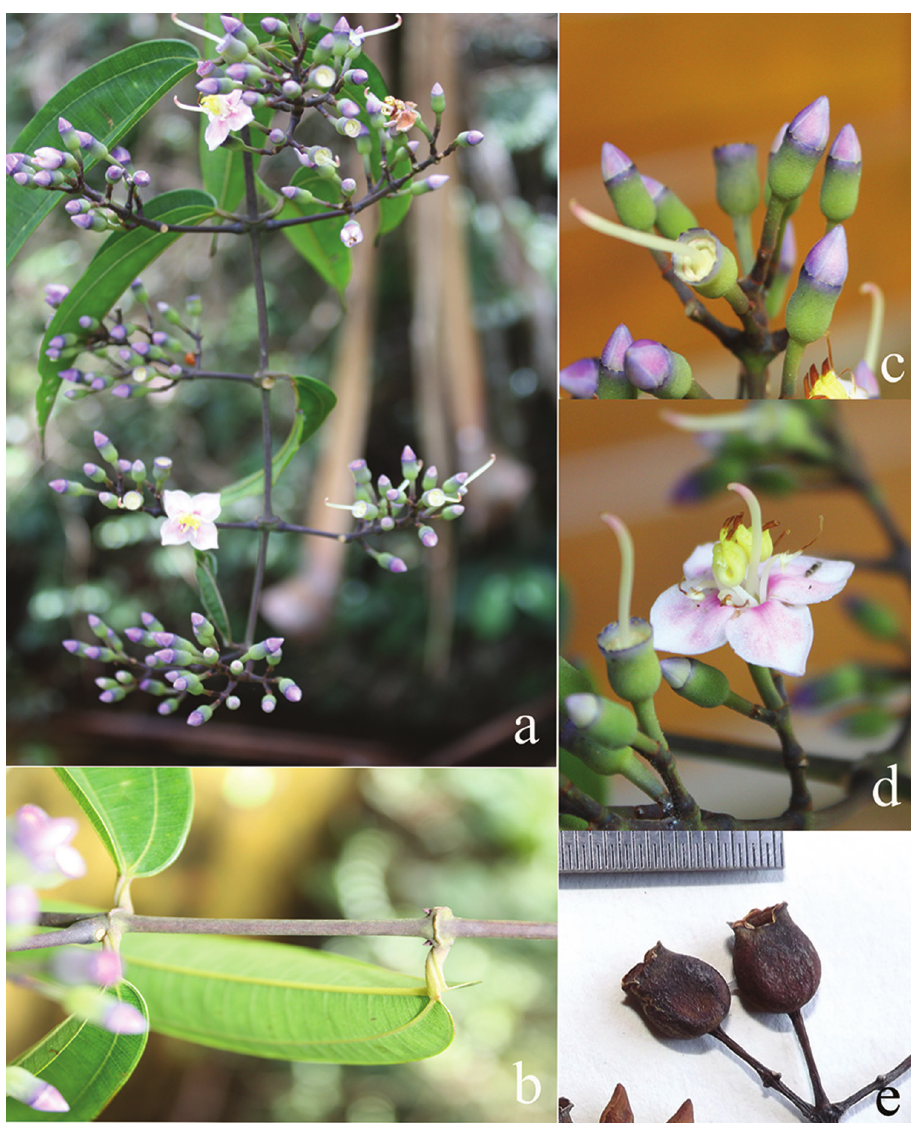
Figure 11. Dissochaeta conica a habit b branchlet c hypanthium d flower e fruits. Photographs by A. Kartonegoro; vouchers: Kartonegoro 1078 (BO, L) & Kartonegoro 1101 (BO, L). long; nervation with 1 pair of lateral nerves and 1 pair of intramarginal nerves; surfaces glabrous. Inflorescences terminal and axillary, when terminal, up to 20 cm long and many-flowered, when axillary, up to 10 cm long and with 3–10 flowers; main axis an- gular, glabrous; primary axes up to 16 cm long with 4 or 5 nodes, secondary axes 1.5–4 cm long with 1–3 nodes, tertiary axes up to 1.5 cm long with 1 node; bracts linear, 2–4 mm long, glabrous, caducous; bracteoles linear, 1–2 mm long, glabrous; pedicels